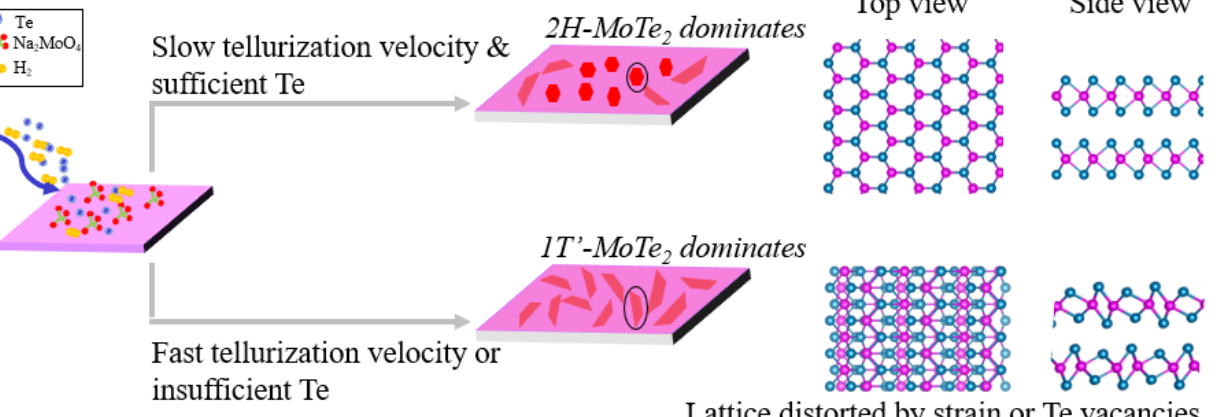
Figure 7. Schematic diagram of the growth mechanism for 2H-MoTe 2 and 1T’-MoTe 2 .